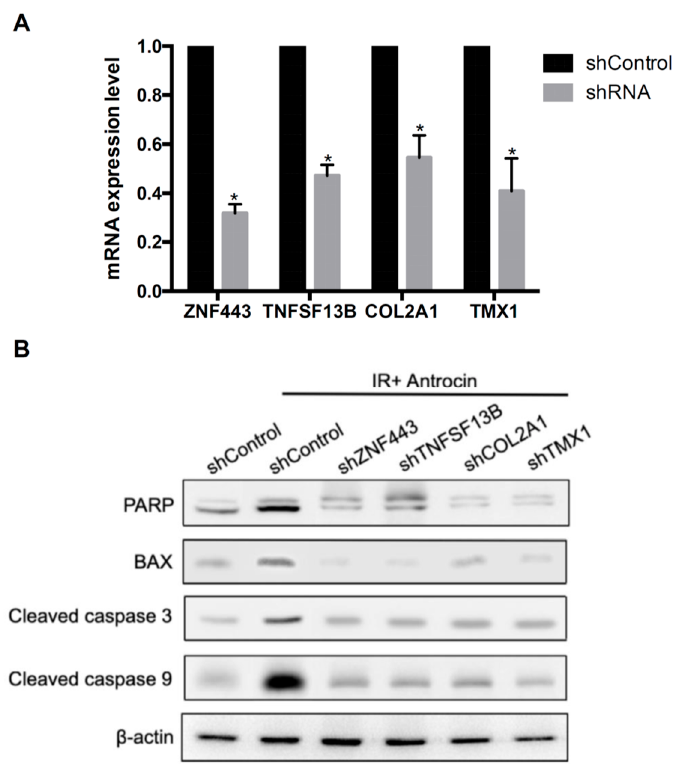
Figure 4. Knockdown of ZNF443 , TNFSF13B , COL2A1 , and TMX1 decreases antrocin and IR-induced apoptosis-related molecule expression. ( A ) mRNA levels in shRNA-Control (shControl) and shRNA knockdown cells were analyzed using qRT-PCR. GAPDH was used as an internal control. * p < 0.01 when compared to each group. ( B ) PC3-KD cells were transfected with shControl or with gene-targeting shRNA. The shControl or shRNA knockdown cells were vehicle-treated or co-treated with IR (2 Gy) and antrocin (100 µ M) for 48 h. Cell lysates were harvested and subjected to Western blot analysis. The data represent one of three independent experiments. β -actin was used as a loading